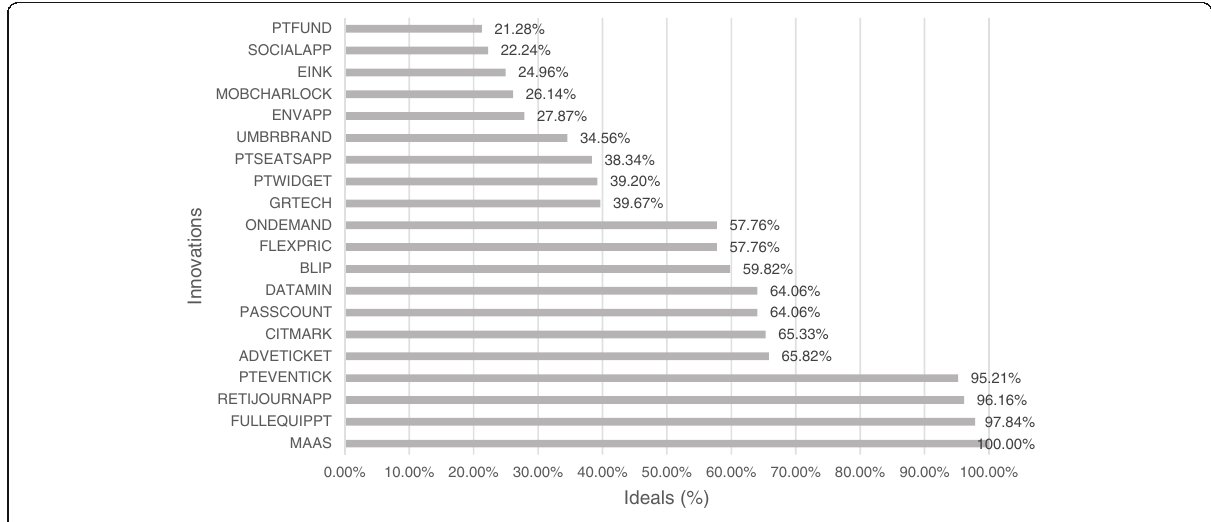
Fig. 5 Ranking of innovations with respect to Utility (Ideals